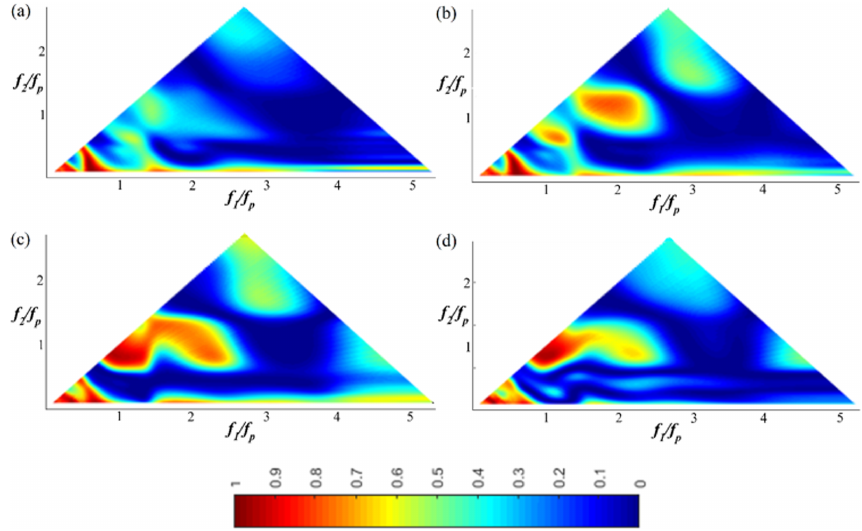
Figure 10. The wavelet-based bicoherence spatial evolution on the sloping bottom for the JONSWAP ( γ = 7) wave train (Test 7). (a) x = 10 . 2m; (b) x = 11m; (c) x = 12 . 4m; (d) x = 13 .